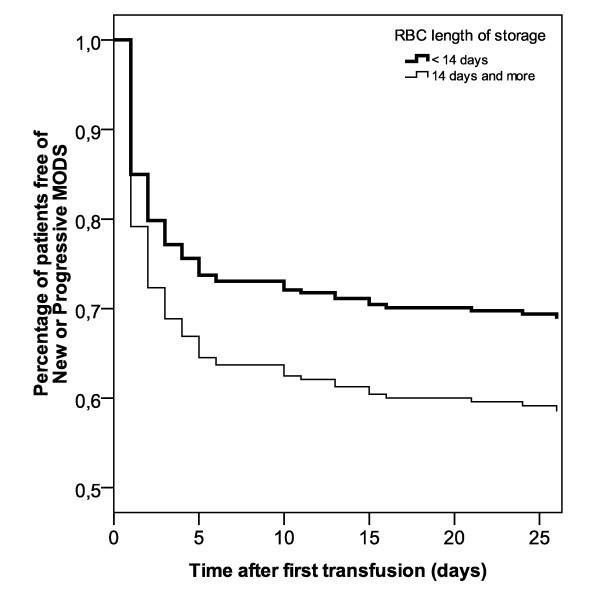
Time to develop new or progressive MODS. Adjusted proportion of patients free of primary outcome (new or progressive multiple organ dysfunction score (MODS)), according to the red blood cell (RBC) length of storage (<14 days versus ≥ 14 days). The Cox regression model was adjusted for gender, age, MODS at admission, mechanical ventilation at admission, total number of transfusions, and total transfusion volume. Hazard ratio = 1.43 (95% CI = 0.96 to 2.15, P = 0.08).